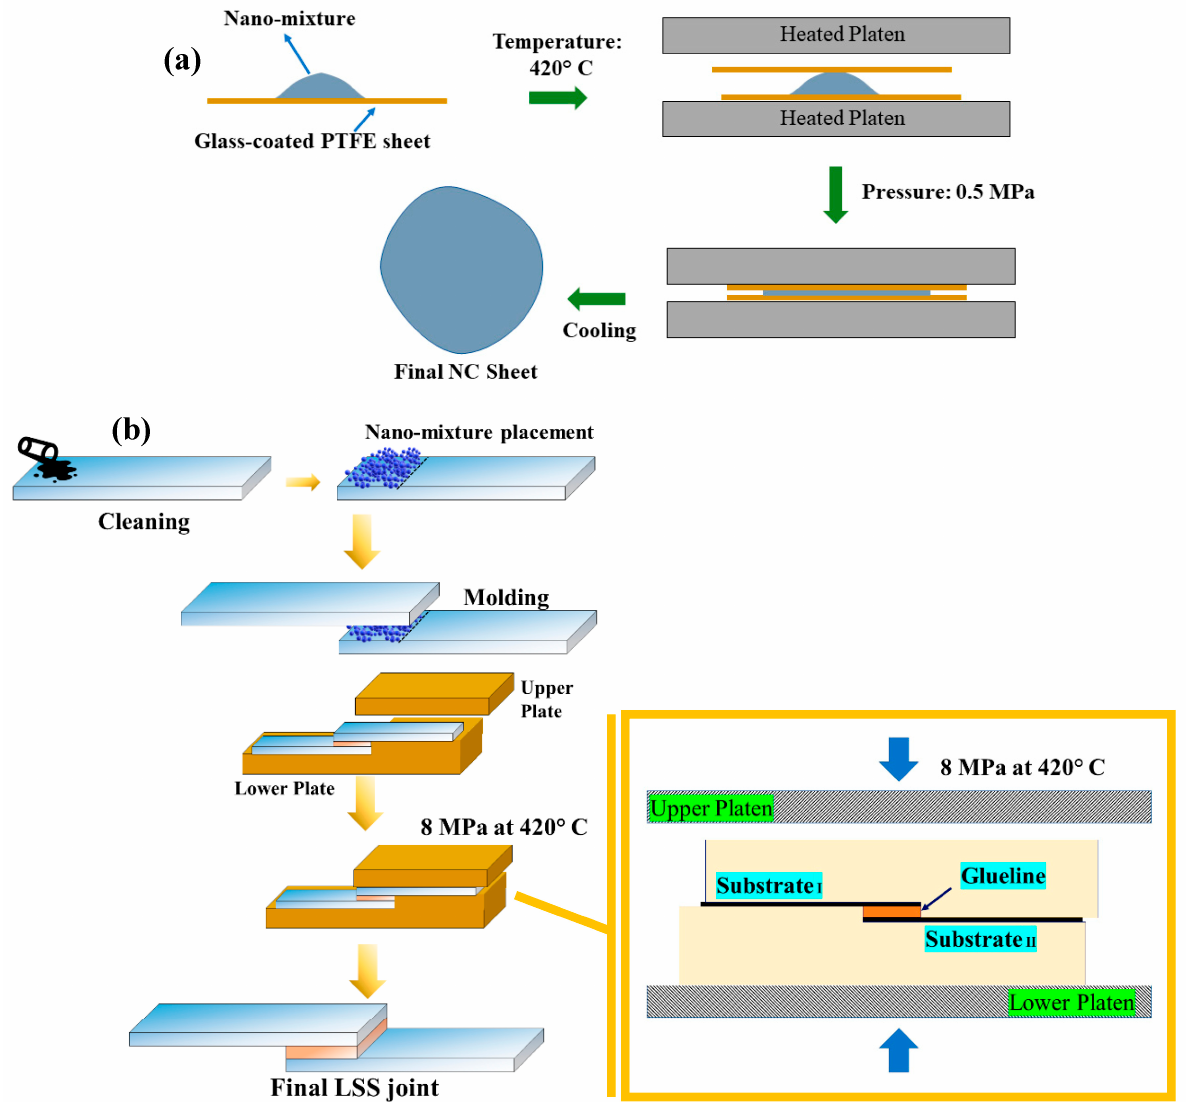
Figure 1. Schematics for ( a ) nanocomposite sheet fabrication and ( b ) the LSS joint preparation pro- cess.